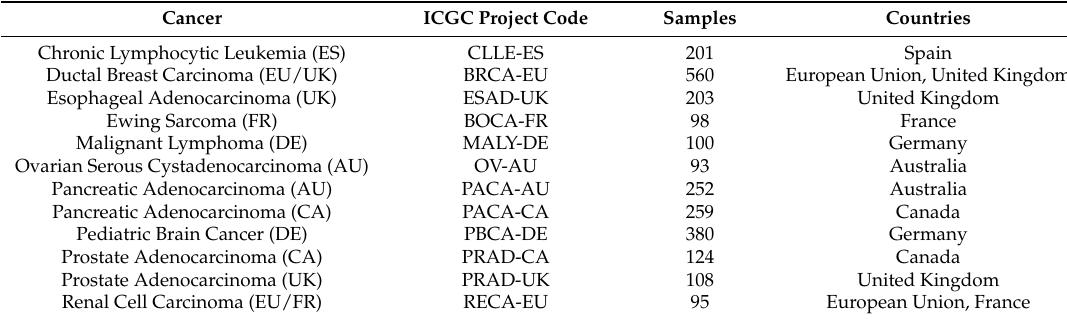
Table 2. Simple somatic mutation datasets used in this work.